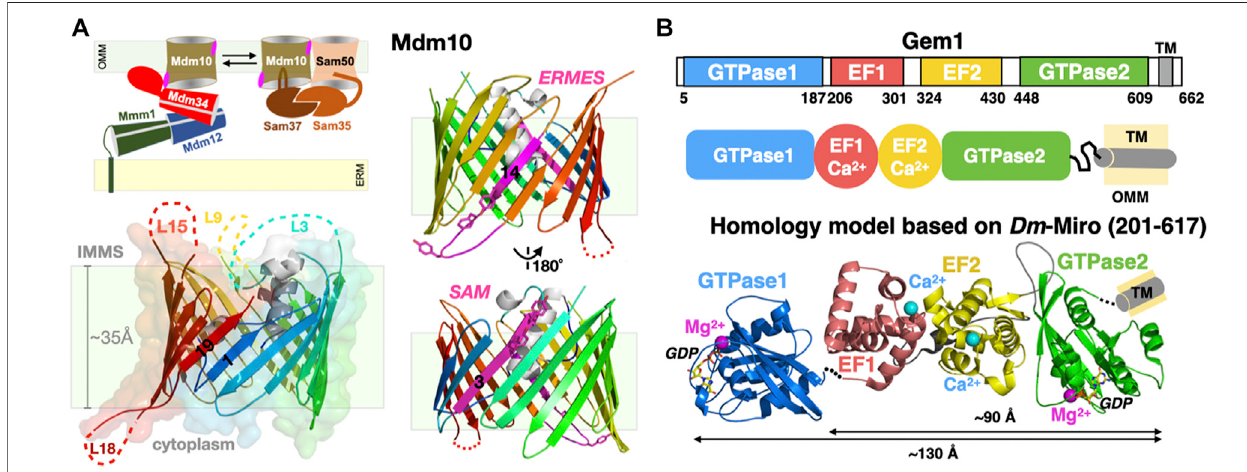
FIGURE 8 | Mitochondrial subunits of ERMES: Porin Mdm10 and Rho1 GTPase Gem1. (A) Mdm10 serves dual functions as component of ERMES and SAM. Transmembrane 19-stranded β barrel structure of Mdm10. The 19 β -strands are colored using a rainbow pattern and strands 1 and 19 forming the lateral gate of the barrel are labeled. Unresolved loops in the cryo-EM structure are indicated; L18 is the only large cytoplasmic loop present in Mdm10. Two views of the Mdm10 barrel colored in rainbow pattern except for the two opposite binding interfaces for ERMES (Y296-F298 and Y301) and SAM (Y73 and Y75) colored in magenta. (B) Domain organization of the tail-anchored mitochondrial GTPase Gem1 and Phyre 2 composite homology model based on the Drosophila/Homo Miro partial X-ray structures.DomainsEF1,EF2andC-GTPase2domainsaremodelled “ enblo ” basedonthe Drosophila/Homo MirostructureswhiletheN-GTPase1domainismodelled basedonthe Homo Mirostructure,althoughitsexactrelativeorientationwithinthefull-length Mirostructure isnotpreciselyknown.Ca 2+ (magenta) andMg 2+ (cyan)ions are drawn as spheres (PDB 7BTY-6D71-6KTY).